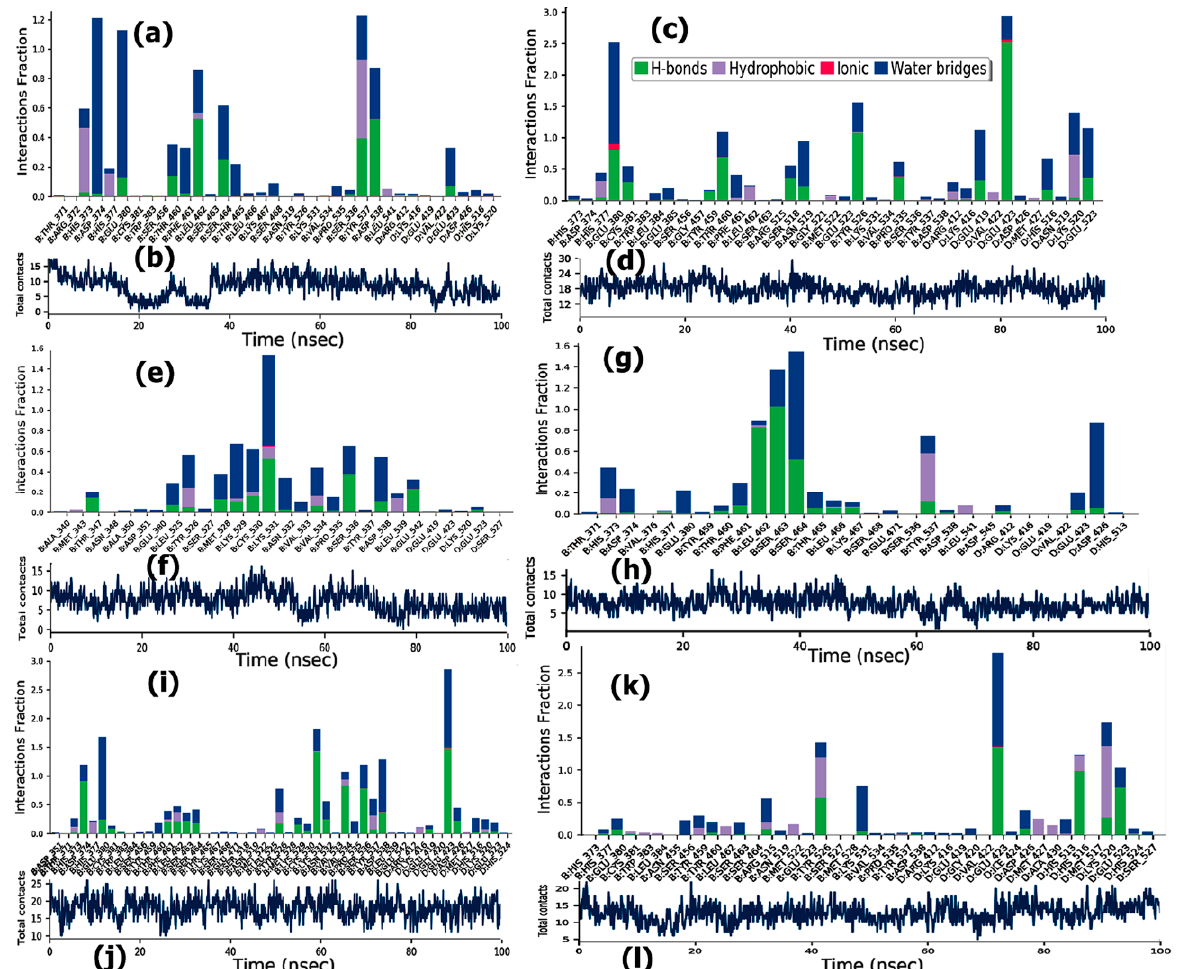
Figure 10. Protein ligand contacts of ER α -ligand complexes. ( a ) with RMAMut1; ( b ) total number of contacts with RMAMut1; ( c ) with RMAPep; ( d ) total contacts with RMAPep; ( e ) with GLAMut1; ( f ) total number of contacts with GLAMut1; ( g ) with GLAMut2 conjugate; ( h ) total number of contacts with GLAMut2; ( i ) with CGAMut4; ( j ) total number of contacts with CGAMut4; ( k ) with CSAMut4; ( l ) total number of contacts with CSAMut4.